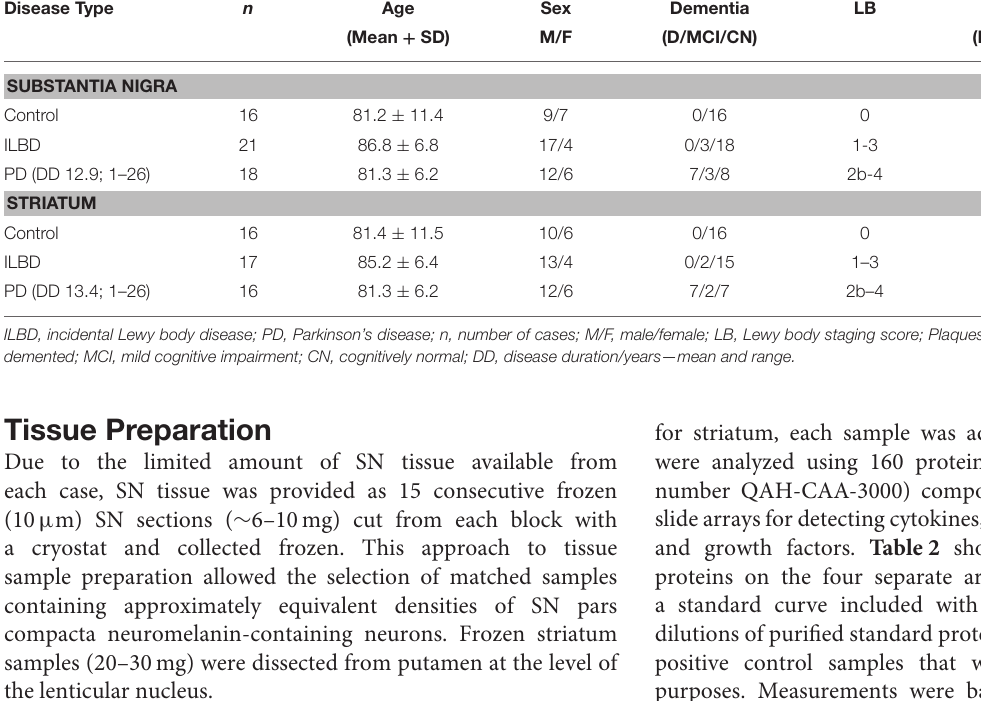
TABLE 1 | Demographic features of cases used in study. Disease